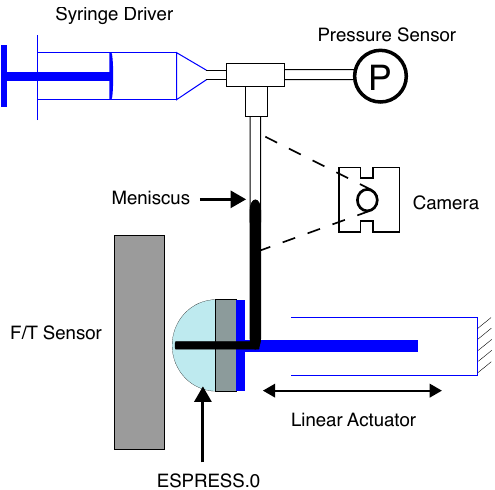
Figure 4. The setup of the ESPRESS.0 prototype with a single channel used to characterise the sensory response. The tubing is all linked, with a 3-way junction adding a pressure